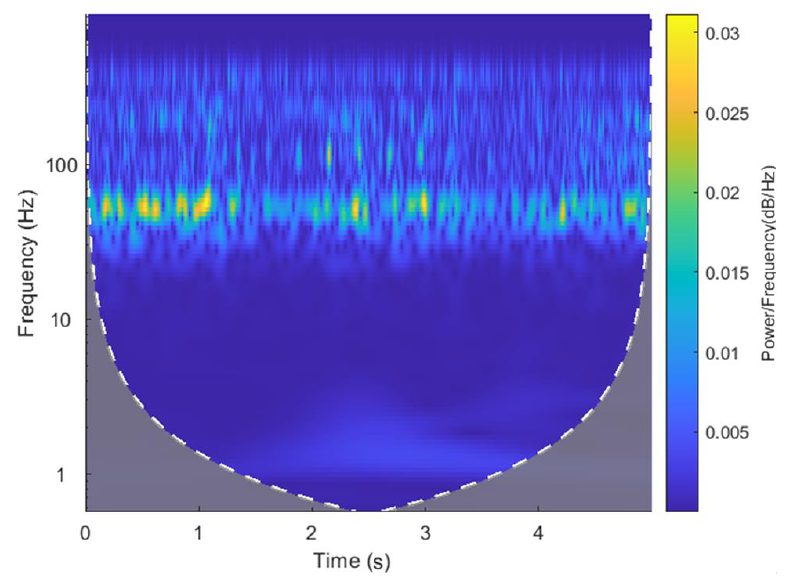
Figure 11. Wavelet-transformed time-frequency image of the measured value from Channel 7.